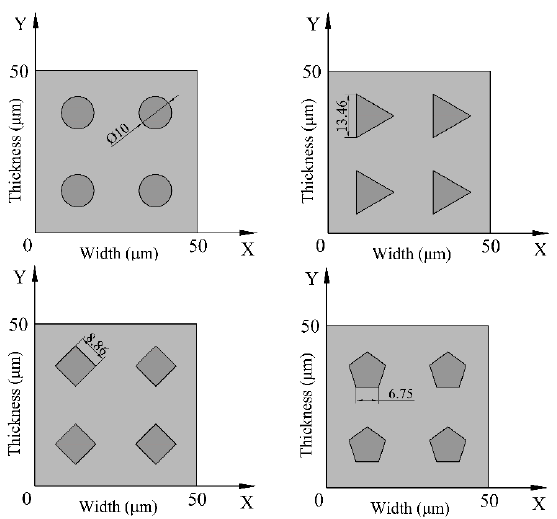
Figure 1. Schematic diagram of the composite models with different shapes.